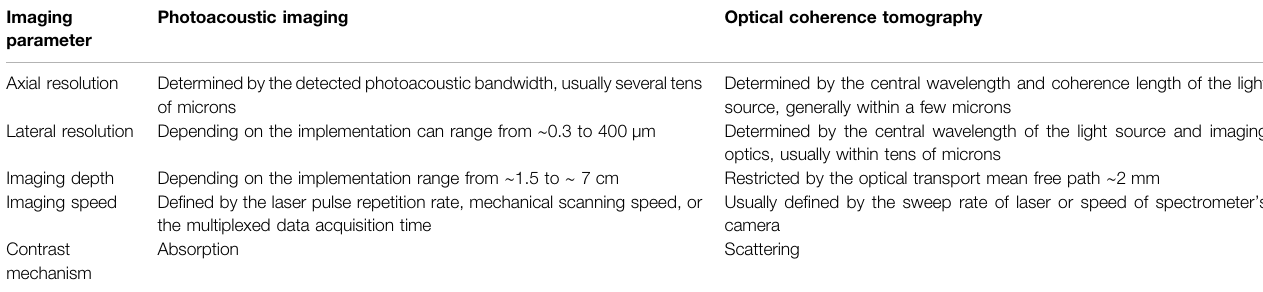
TABLE 1 | Comparison of photoacoustic imaging and optical coherence tomography. Imaging Photoacoustic imaging Optical coherence parameter